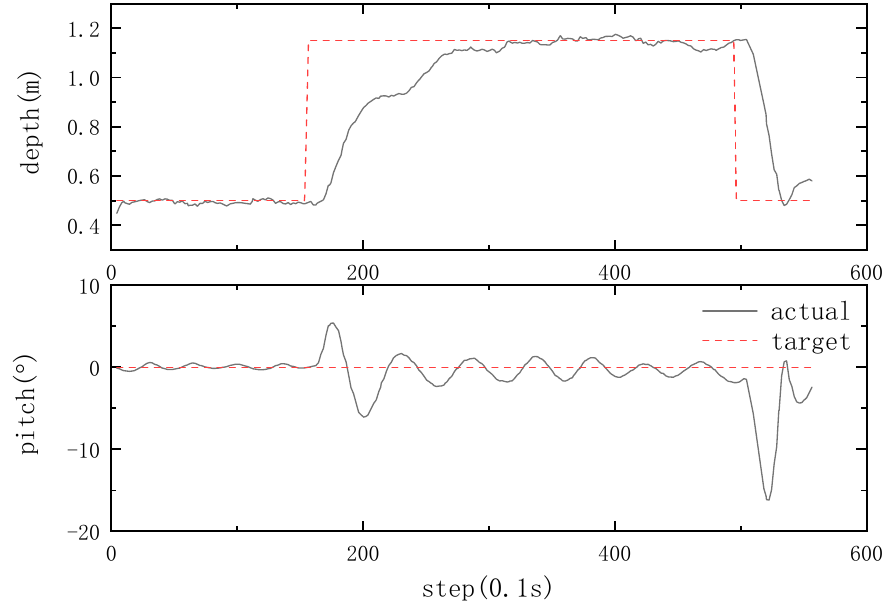
Figure 17. Automatic control of the velocity.